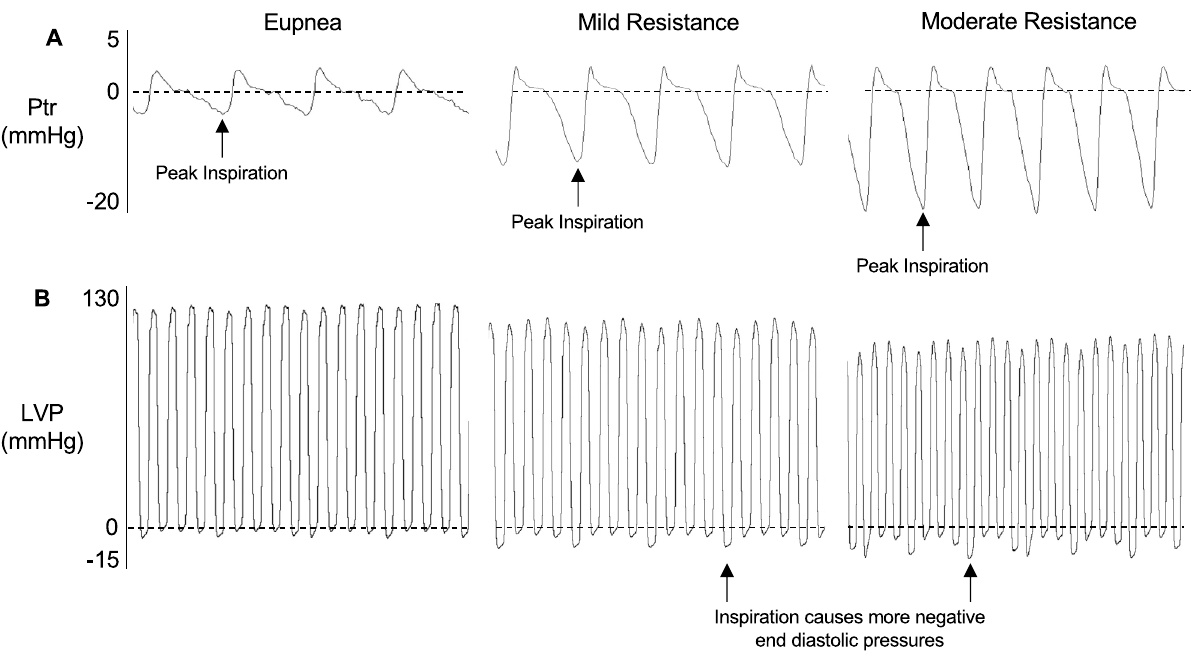
Figure 1. Assessment of tracheal pressure and invasive hemodynamics. Representative tracings of tracheal pressure (Ptr) ( A ) and left ventricle pressure (LVP) ( B ) during eupnea, mild, and moderate resistance